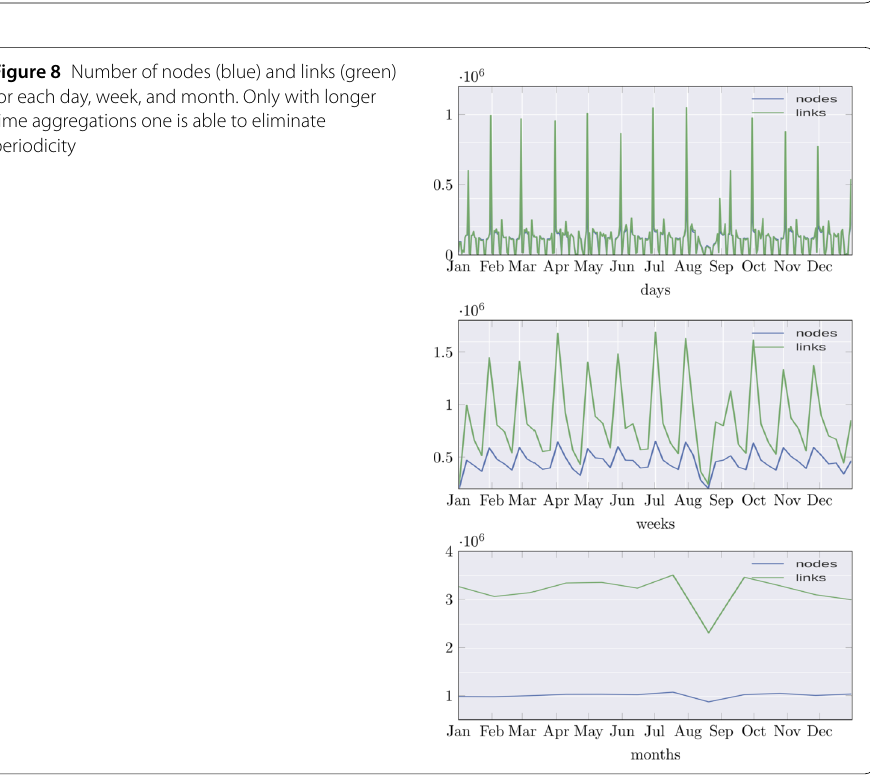
Figure 7 Histogram for the number of days, weeks, months of activity for nodes (blue) and existence for edges (green) for different time aggregations